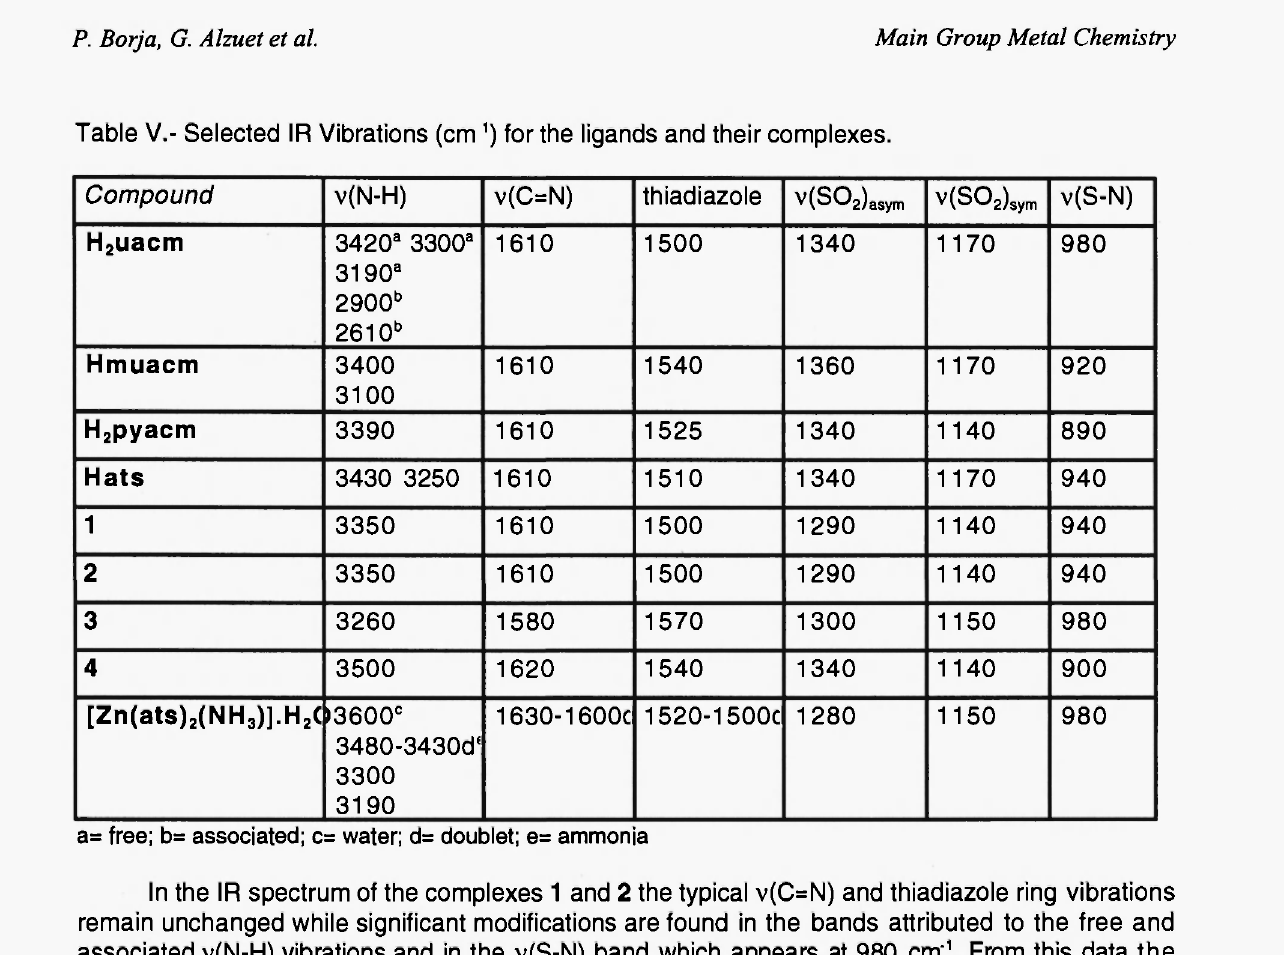
Table V.- Selected IR Vibrations (cm 1 ) for the ligands and their complexes.